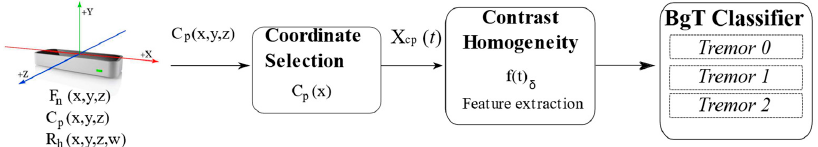
Figure 2. Block diagram of the analysis of tremors for Parkinson’s classification. BgT: bagged Figure 2 . Block diagram of the analysis of tremors for Parkinson´s classification. BgT: bagged tree.